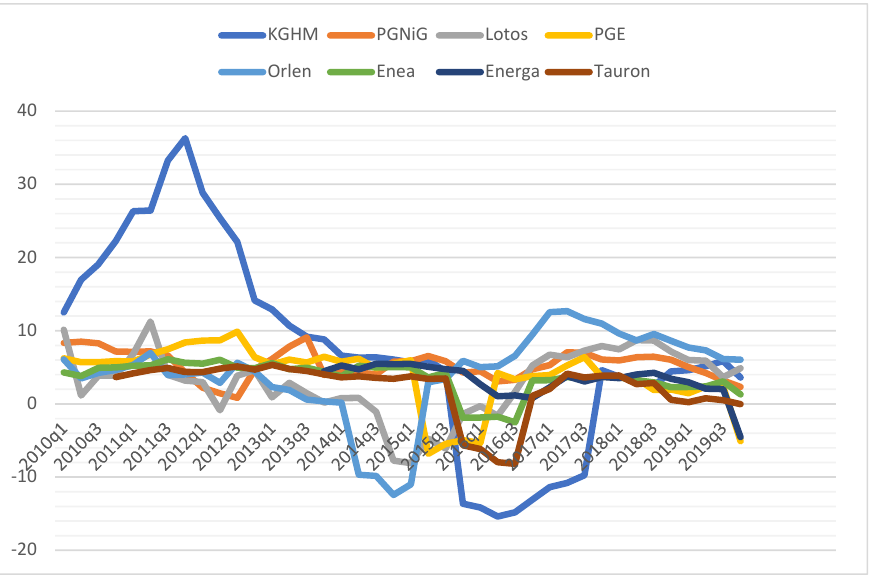
Figure 4. Values of return on assets (ROA) indicator noted by analysed enterprises in the period 2010–2019. Source. Self-analysis.